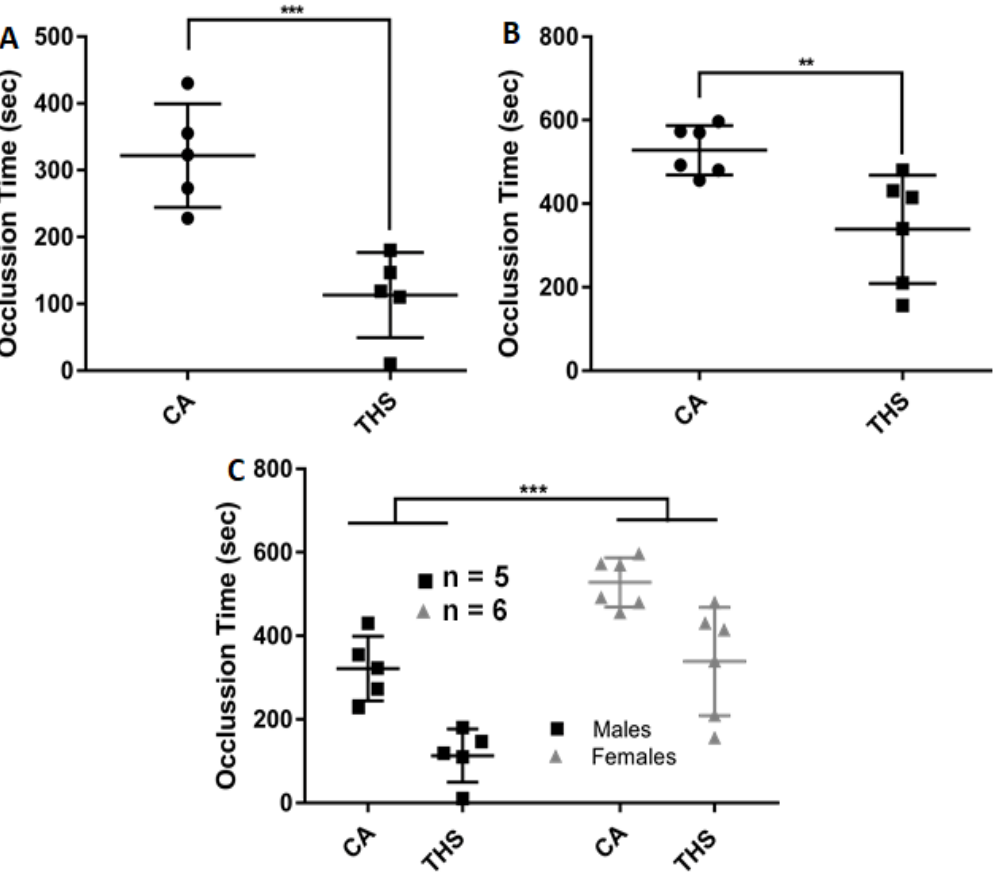
Figure 5. THS-exposed mice showed decreased occlusion times. THS-exposed and CA-exposed ( A ) male and ( B ) female mice were anesthetized with avertin and carotid injury-induced thrombosis was induced with a FeCl 3 solution as described in the methods section. Intersex differences are shown in panel ( C ). Each point represents the occlusion time of a single animal (** p < 0.01; *** p < 0.001).